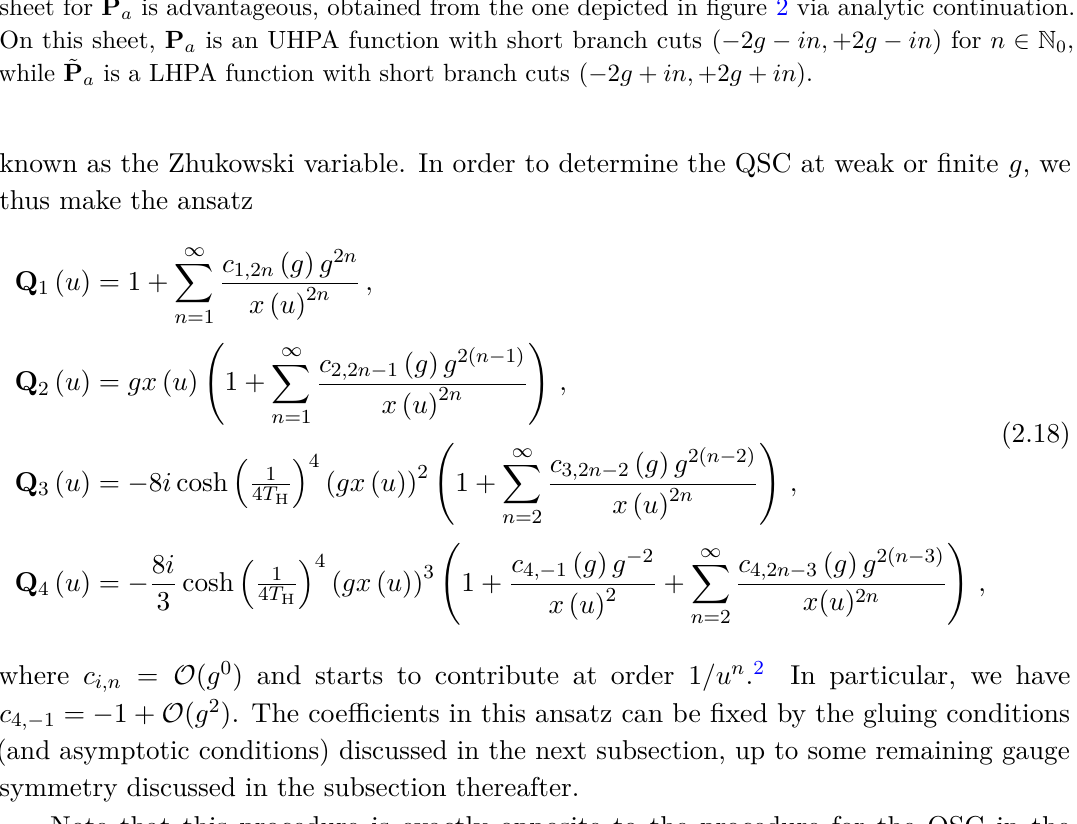
Figure 3. For the purpose of solving the QSC for the Hagedorn temperature, a different Riemann sheet for P a is advantageous, obtained from the one depicted in figure 2 via analytic